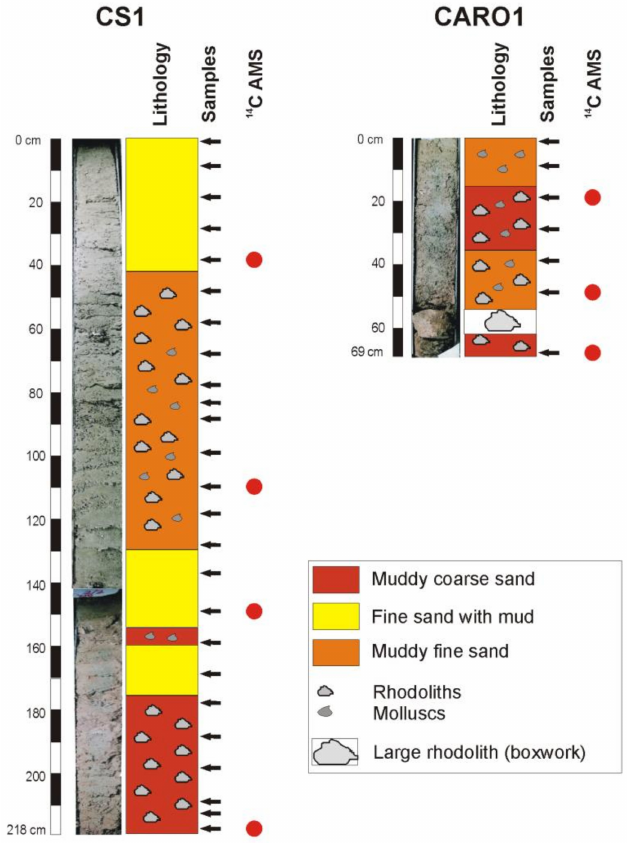
Figure 2. Lithological scheme of the studied cores, with samples (black arrows) and position of radiocarbon-dated levels (red